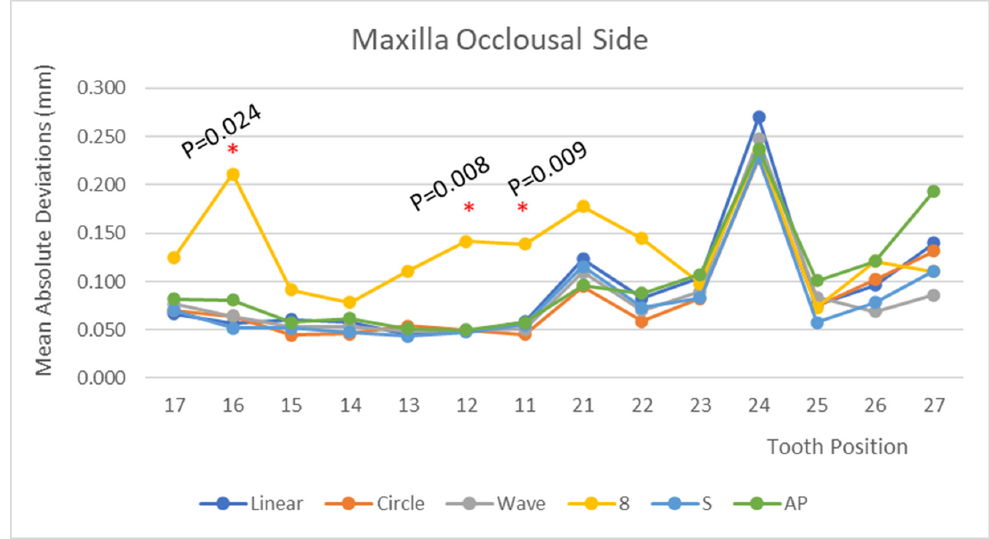
Figure 4. Occlusal deviations at different tooth positions among six head movements in the maxilla. * Statistically different at tooth position among six movements.